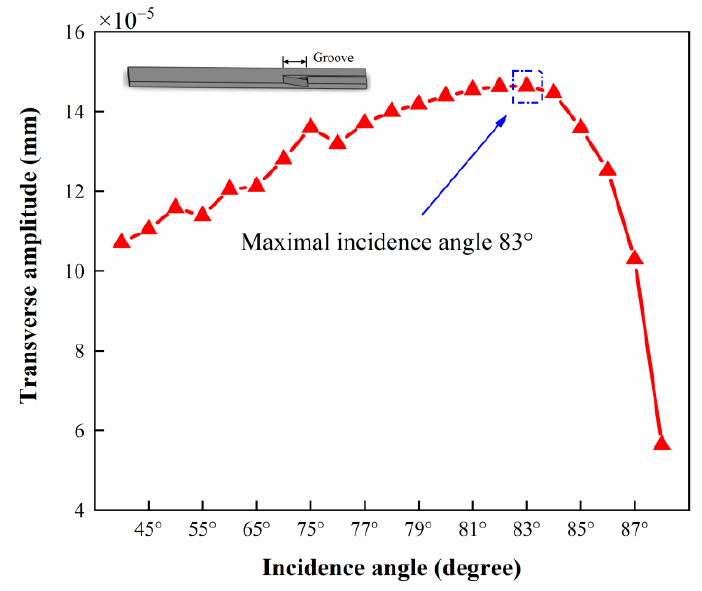
Figure 12. Transverse amplitudes with different incidence angles.